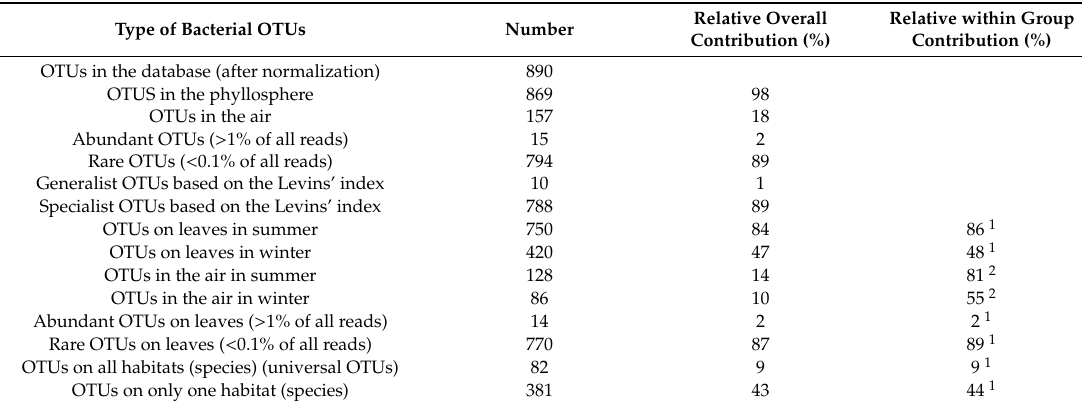
Relative Overall Relative within Group Contribution (%) Contribution (%) 890